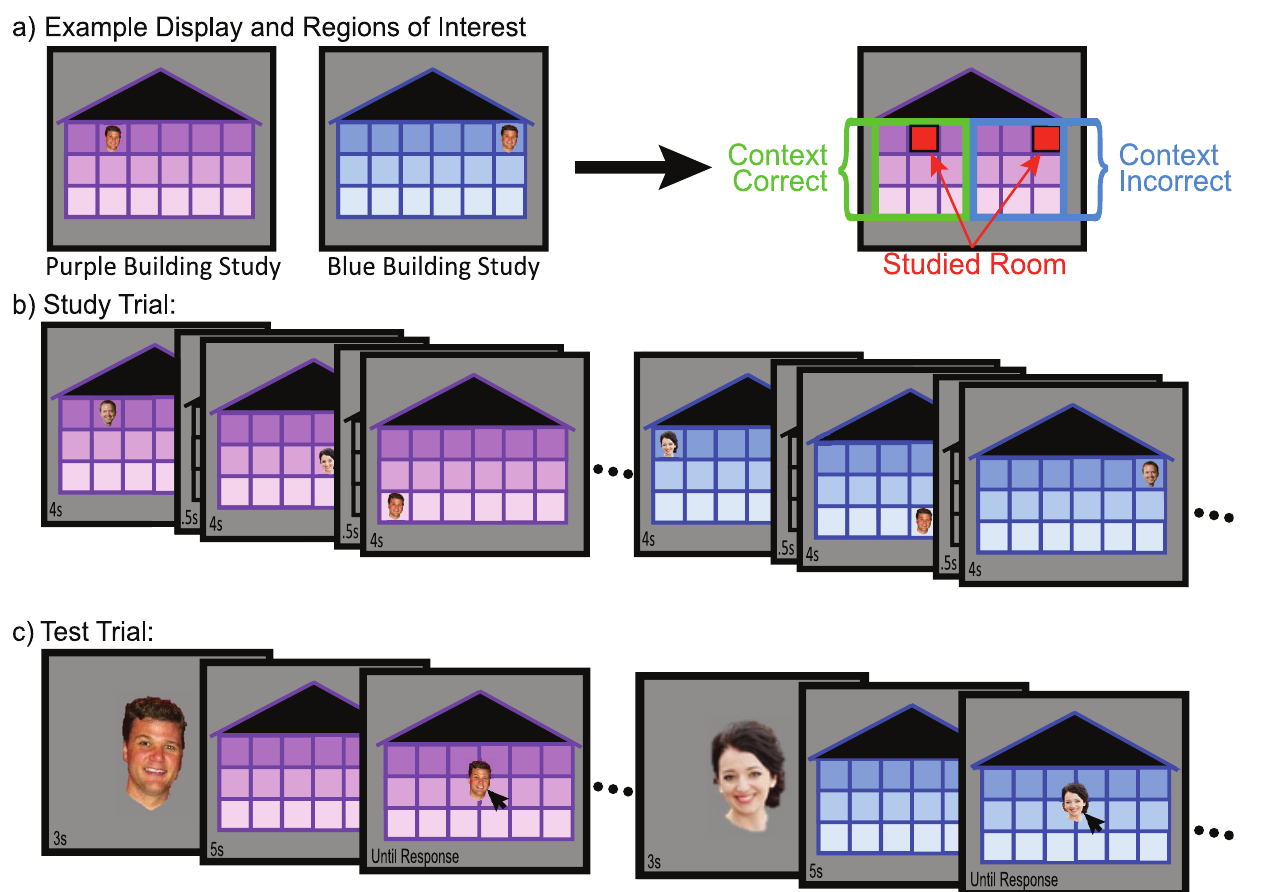
Fig 1. Stimuli and design in the novel context-dependent relational memory test. (a) General display information and resulting regions of interest. (b) Study phase design and timing information. (c) Test phase design and timing information.